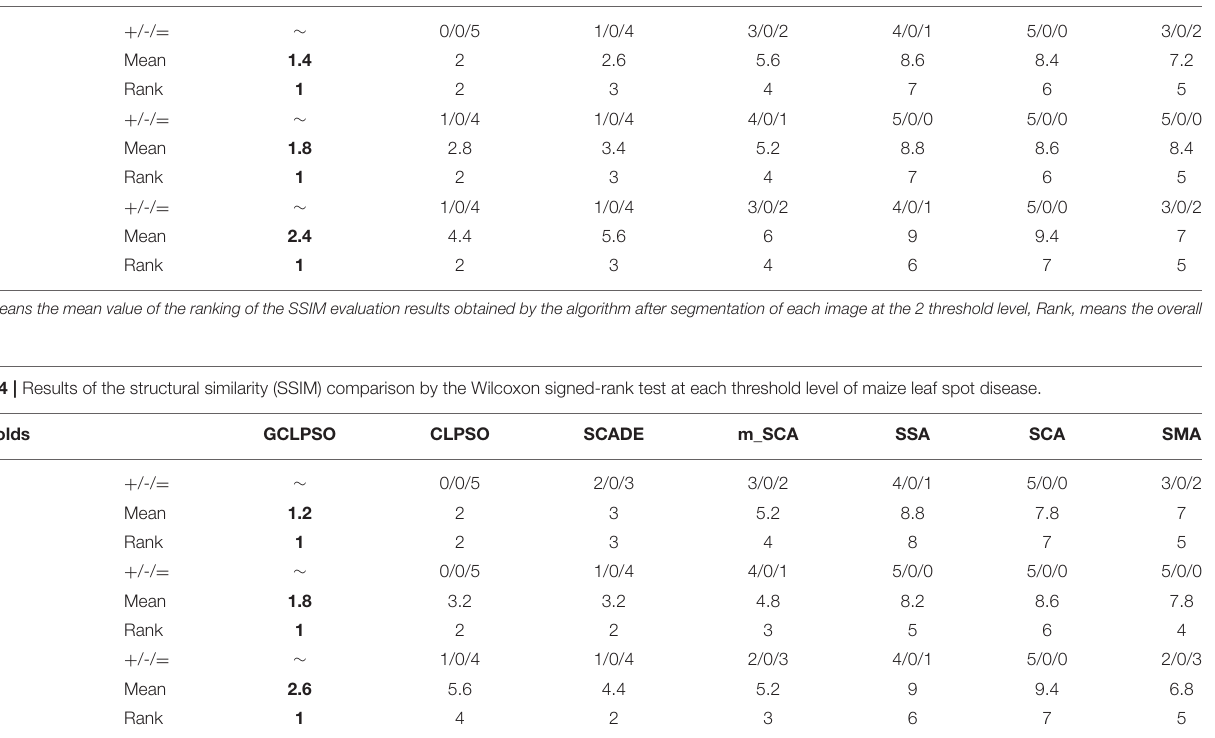
TABLE 3 | Results of the peak signal-to-noise ratio (PSNR) comparison by the Wilcoxon signed-rank test at each threshold level of maize leaf spot disease. Thresholds